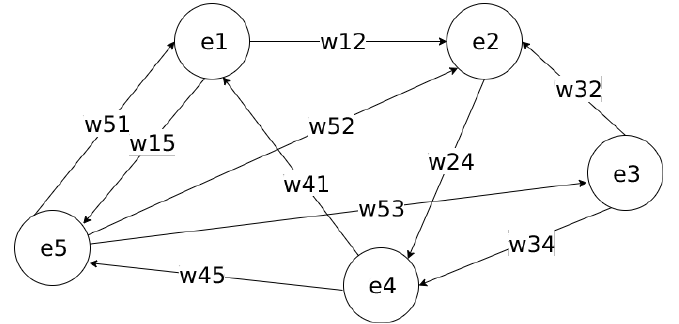
Figure 1. Simple fuzzy cognitive map